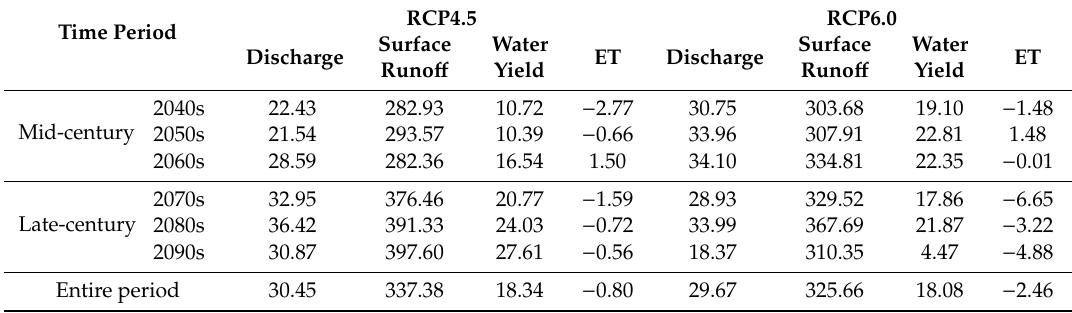
Table 8. Percent changes to surface runo ff , water yield, ET, and discharge based on the GCMs and under di ff erent